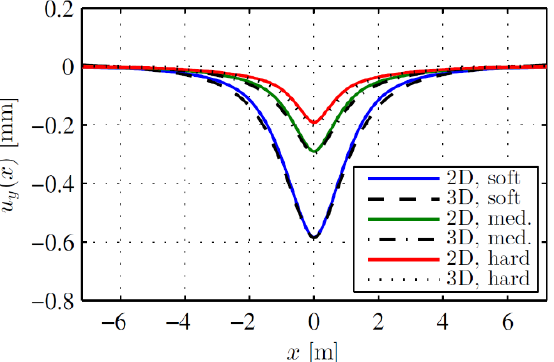
Figure 13. Vertical displacement of the rail for the 3D FE model and the DSM for h b = 0.6 m, h s = 6 m and different combinations of E b and E s .